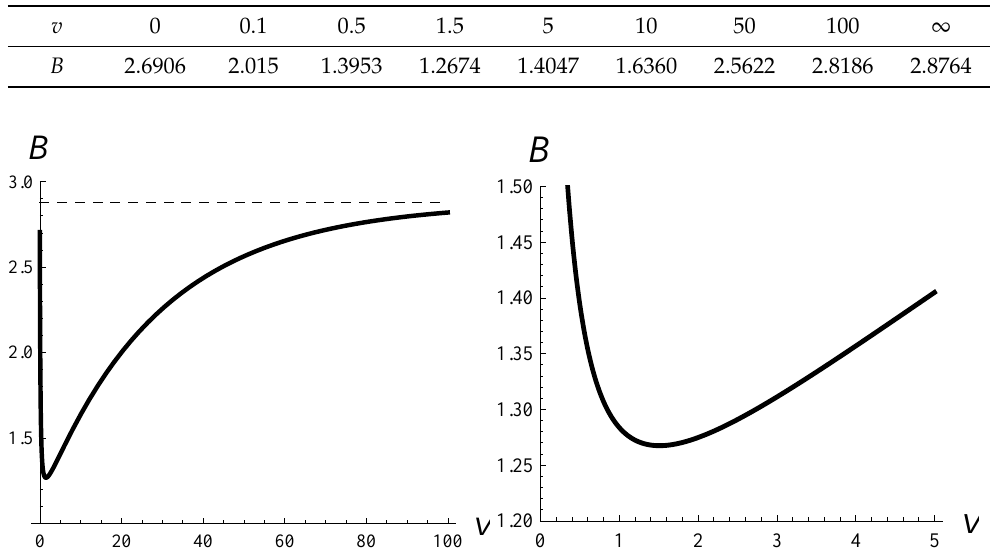
Figure 3. Burst ratio versus parameter v when dropping function d v